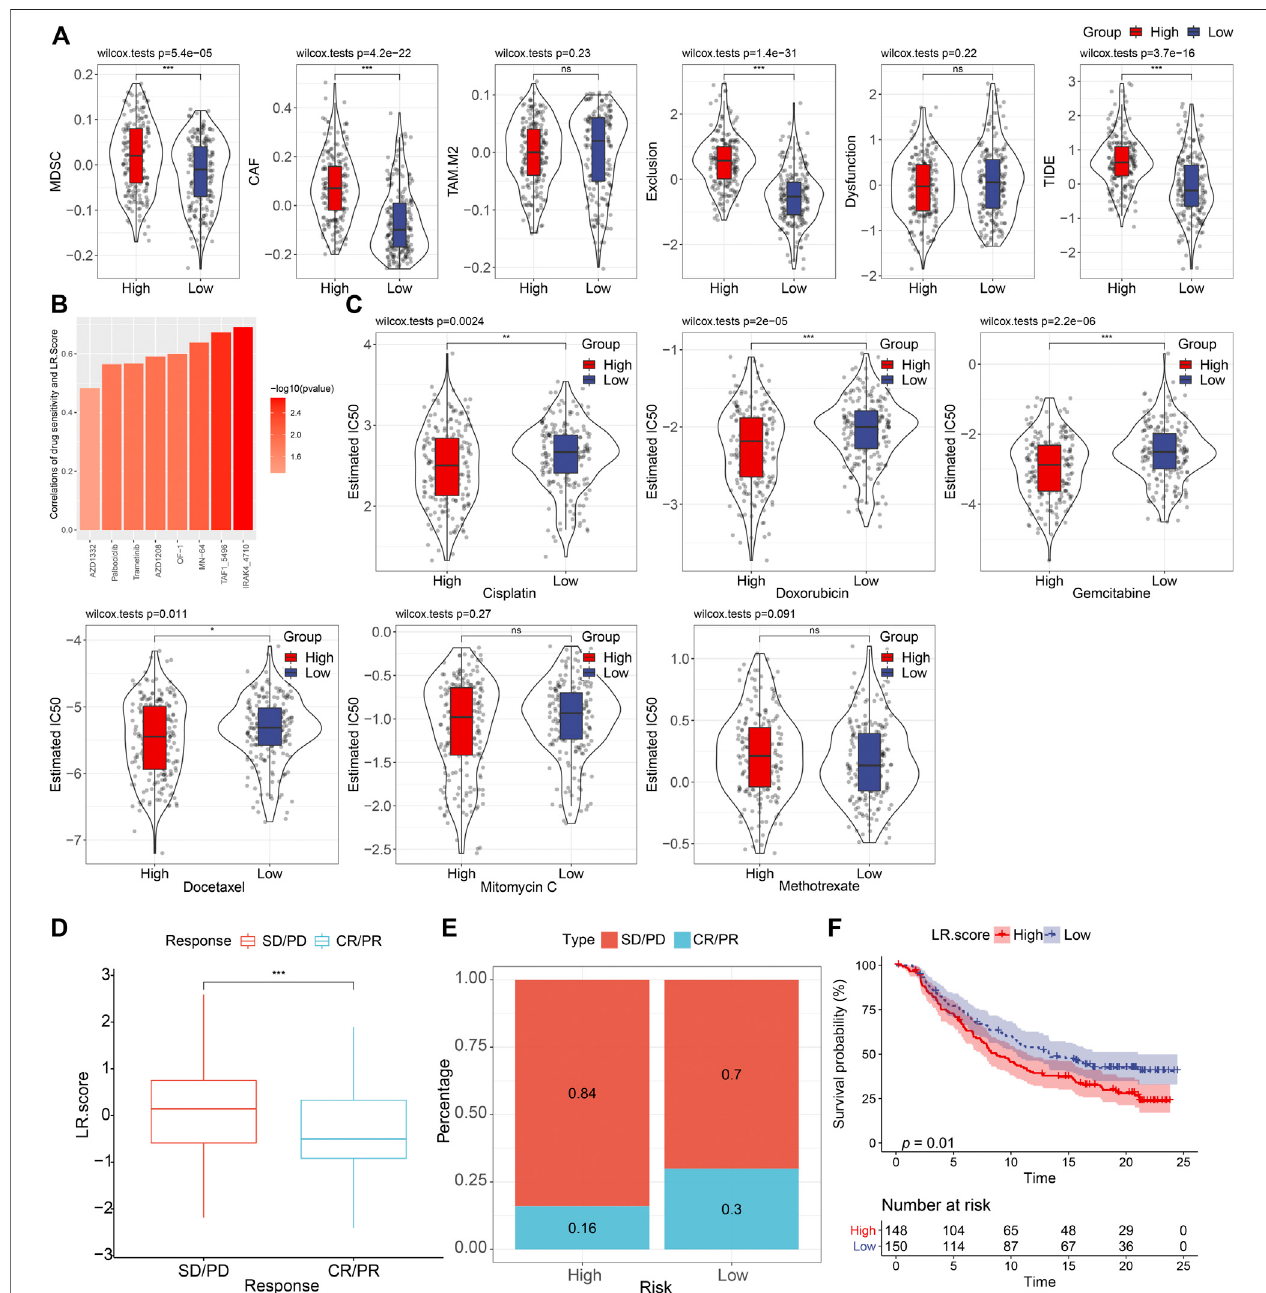
FIGURE8| DrugpredicationsbasedontheLR.score (A) .DistributionsofMDSC,CAF,TAM.M2,Tcellexclusion,Tcelldysfunction,andTIDEscorebetweenhigh- and low-LR. score groups. ns, p > 0.05; *** p < 0.001. Wilcoxon rank-sum test. (B) . Bar plot of the spearman correlations of drug sensitivity and LR. Score. (C) . DistributionsoftheEstimatedIC50ofCisplatin,Doxorubicin,Gemcitabine,Docetaxel,MitomycinC,andMethotrexatebetweenhigh-andlow-LR.scoregroups.ns, p > 0.05; * p < 0.05; ** p < 0.01; *** p < 0.001. Wilcoxon rank-sum test. (D) . The fraction of SD/PD, and CR/PR, shown in high- and low-LR. score groups. (F) . Kaplan – Meier curve of the overall survival between high- and low- LR. score groups ( p = 0.01).